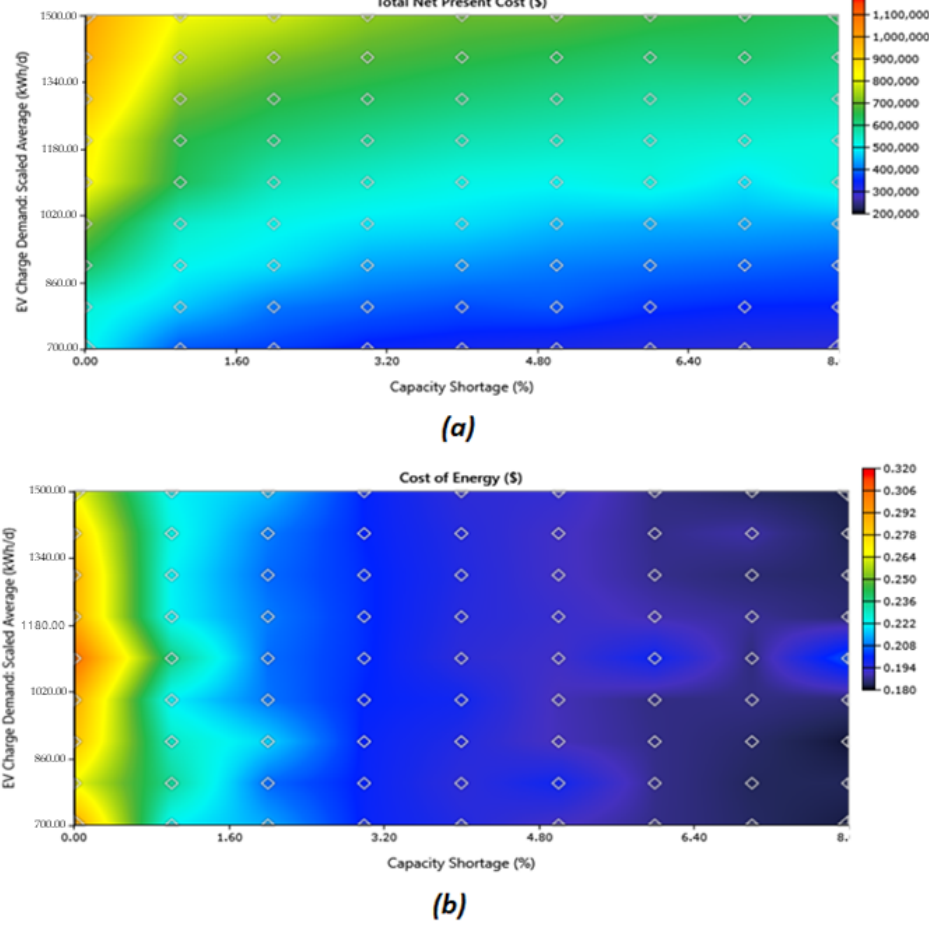
Figure 13. Effect of the sensitivity parameters on the ( a ) total NPC, and ( b ) cost of electricity of the optimal charging station.